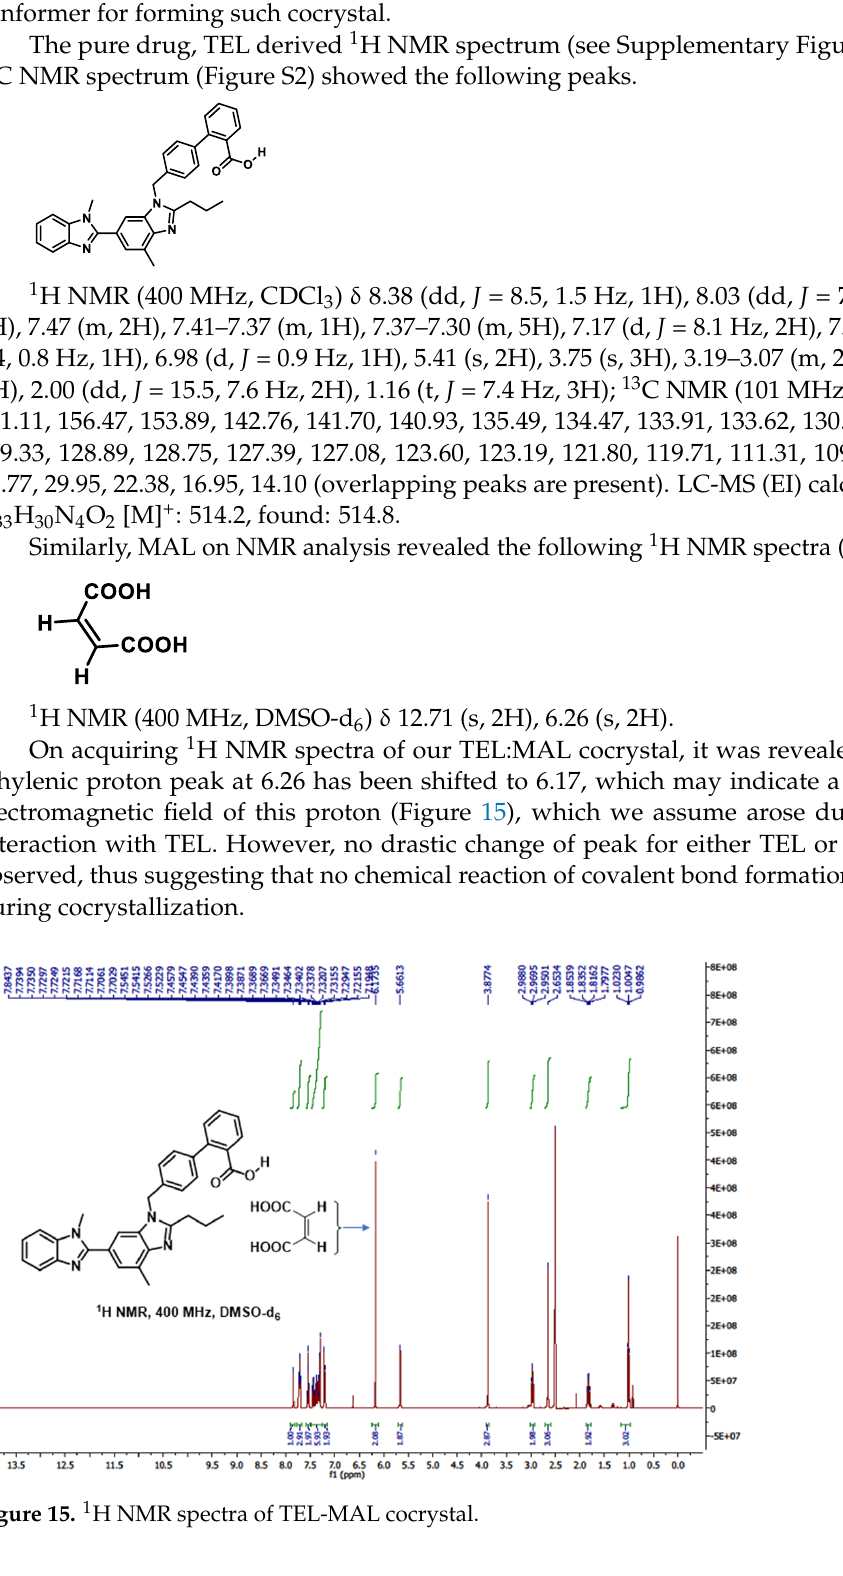
Figure 15. 1 H NMR spectra of TEL-MAL cocrystal . Moreover, the –COOH peak of maleic acid (δ 12.71 (s, 2H)) was totally absent from the cocrystal NMR spectrum. We presume that this is due to the partial ionization of the maleic acid into maleate anion, causing it to lose its acidic proton. Also, the peaks in pure TEL such as 8.38 and 8.03 (likely contributed by the aromatic protons next to – COOH) were shielded in the cocrystal NMR, suggesting the change of electronic field of – COOH after incorporation of the MAL. Thus, it may be inferred that TEL – COOH and MAL – COOH have participated actively in forming the cocrystal. In order to study the interactions more in depth in 3D chemical space, we performed 2D 1 H- 13 C HMBC analysis of the cocrystal (Figure 16).